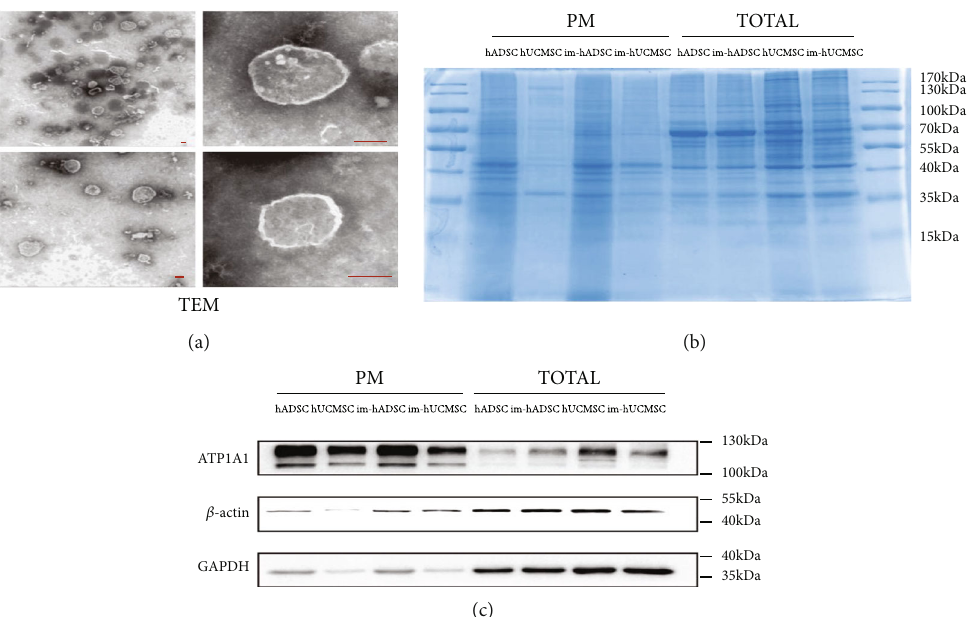
Figure 6: Extraction of mesenchymal stem cell membrane. (a) TEM image of mesenchymal stem cell membranes under electron microscope. (b) The expression pro fi le of proteins in PM and whole-cell lysates of MSCs or im-MSCs were analyzed using SDS-PAGE. (c) The expression levels of ATP1A1, β -actin, and GAPDH in PM and whole-cell lysates were evaluated using western blot. Scale bar, 100nm. TEM: transmission electron microscope; PM: plasma